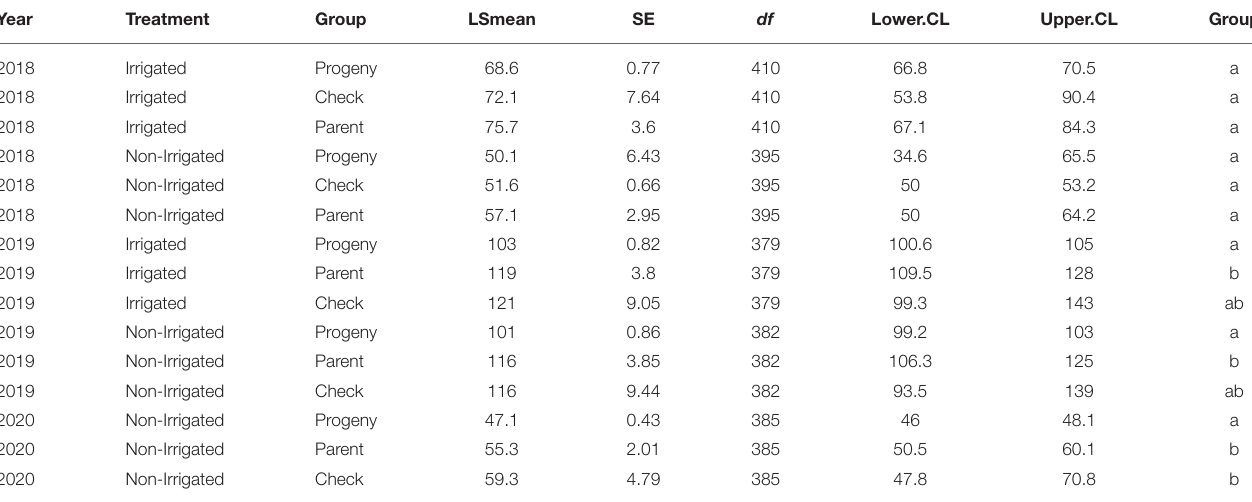
TABLE 1 | Comparison of grain yield (GY) between introgression lines (ILs; progeny) and controls (checks/hexaploid parents) per treatment within a year using least squares (LS) means.